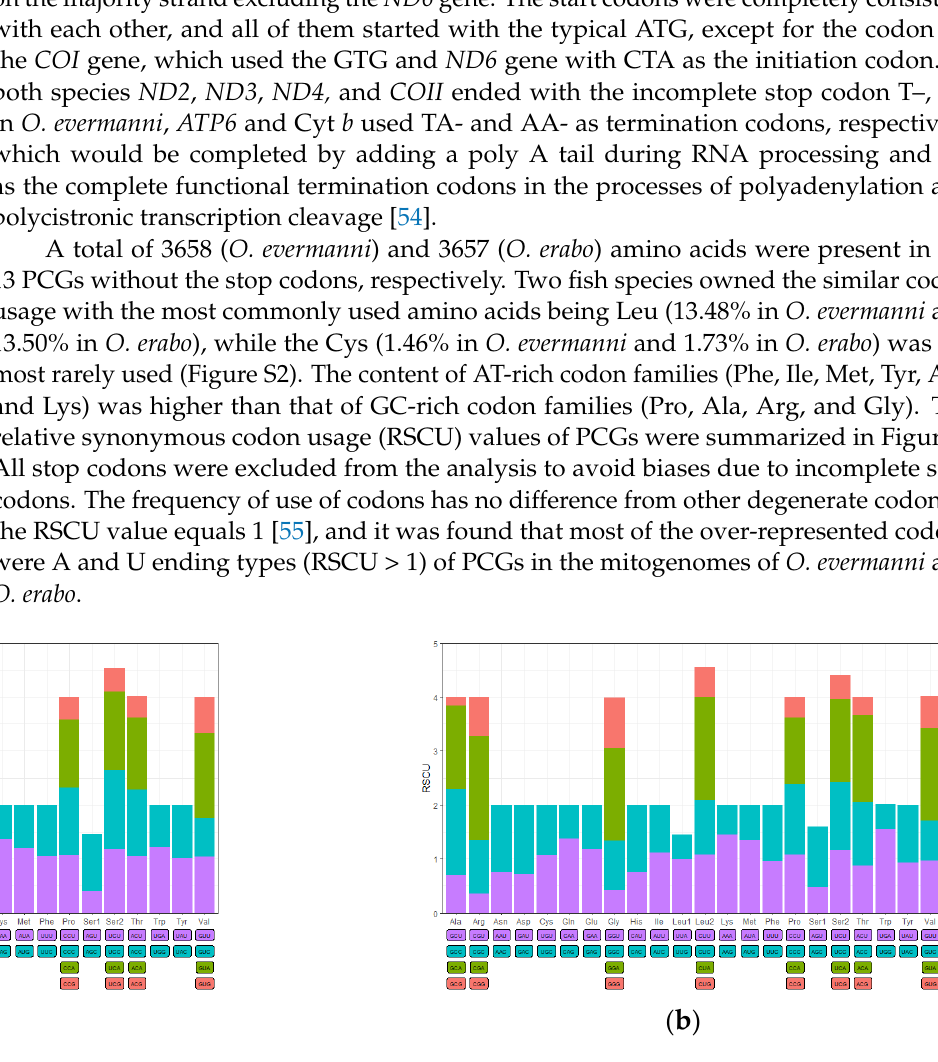
Figure 2. Relative synonymous codon usages (RSCUs) in the mitogenomes of ( a ) O. evermanni and ( b ) O. erabo. Bars of different colors correspond to the codons with the same color.